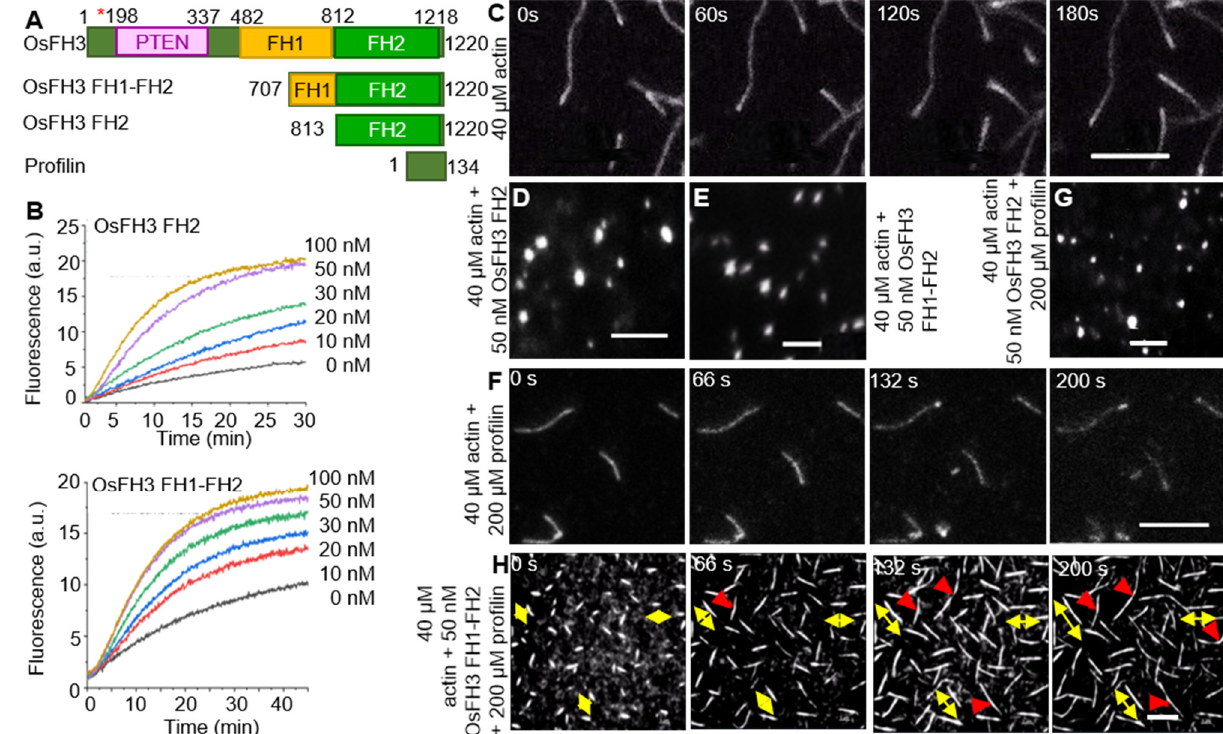
Figure 4. OsFH3 nucleates actin and promotes formation and connection of AF. ( A ) Schematic diagram of OsFH3 structure, indicating FH1–FH2 and FH2 constructs used for actin testing. Amino acid positions in the full-length protein are given. Red asterisk indicates mutation position in osfh3 mutants. PTEN, phosphatase, and tensin homolog domain. Profilin is PRF4 from Arabidopsis. ( B ) Time course of actin nucleation in the presence of OsFH3 FH2 (above) or OsFH3 FH1–FH2 (below). Pyrene fluorescence (a.u., arbitrary units) is proportional to nucleation. ( C – E ) The effect of OsFH3 domains on AF elongation visualized by time-lapse fluorescence microscopy. Fluorescence shows Oregon Green-labeled actin, showing AF elongation, in the actin-only experiment ( C ); and stalled elongation of AF ( D , E ) in the presence of OsFH3 FH2 and OsFH3 FH1–FH2 protein segments. Bar = 5 µm. ( F – H ) The effect of OsFH3 domains on AF elongation and bundling in the presence of profilin visualized by time-lapse fluorescence microscopy. Fluorescence shows Oregon Green-labeled actin. Actin and profilin only ( F ); actin, profilin, and OsFH3 FH2 ( G ); actin, profilin, and OsFH3 FH1–FH2 ( H ). Yellow arrows in H indicate bi-directional elongation of AF. Red arrows indicate connection of AF. Bar = 5 µm.